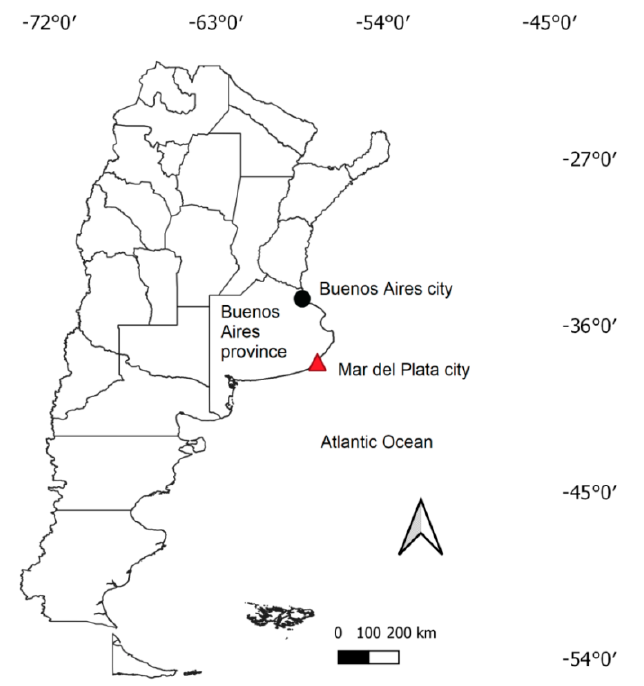
Figure 1. Location of Buenos Aires province, Buenos Aires city, and Mar del Plata city in Argentina.